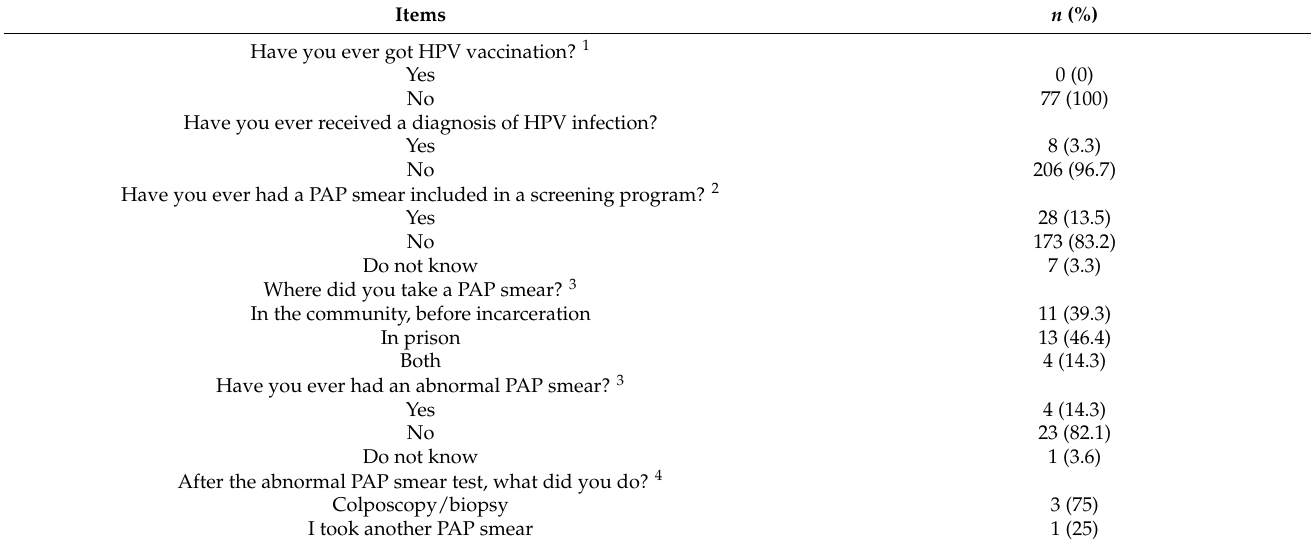
Table 3. Behaviors towards HPV infection and cervical cancer prevention and